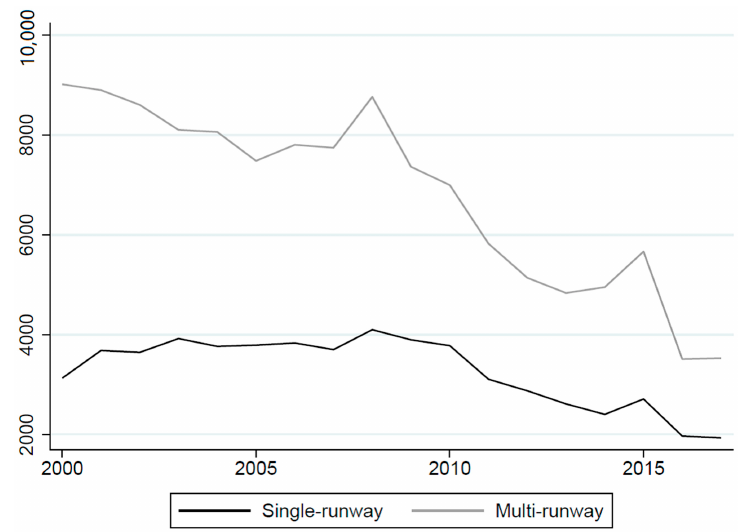
Figure 2. Annual average piston-engine IFR operations at single-runway and multi-runway airports in North Carolina, 2000–2017. Note: Annual averages were calculated using CEM weights assuming a 2 km treatment group (explained in Section 5). a 2 km treatment group (explained in Section